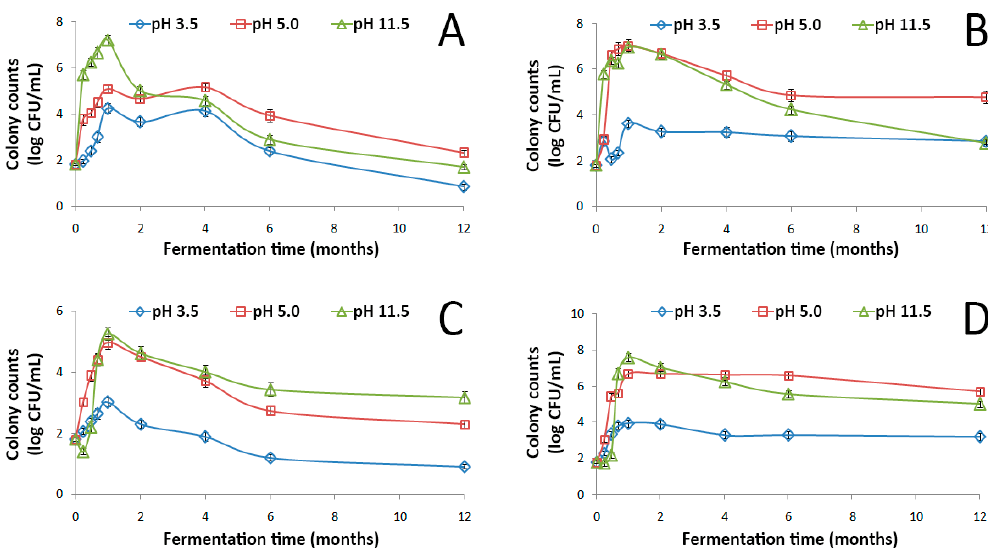
Figure 1. Changes in the population of LAB during the spontaneous fermentation of Spanish-style green olive processing wastewaters with an initial pH value of 3.5, 5.0 or 11.5 at 15 °C ( A ), 30 °C ( B ), 50 °C ( C ), and room temperature ( D ). Data points are mean values of 5 independent experiments × 3 measurements ( n = 15) and error bars represent the standard deviation of the mean value.